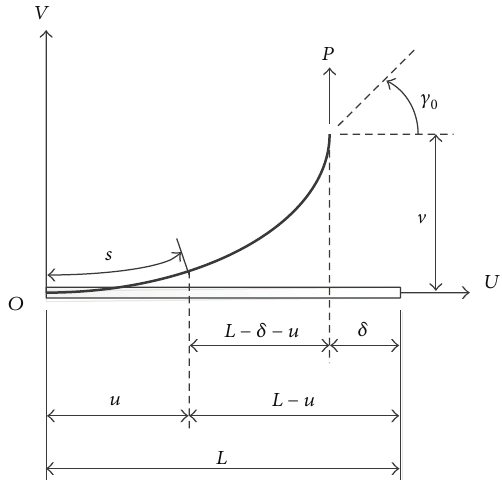
Figure 5: Large deflection of cantilever beam under concentrated